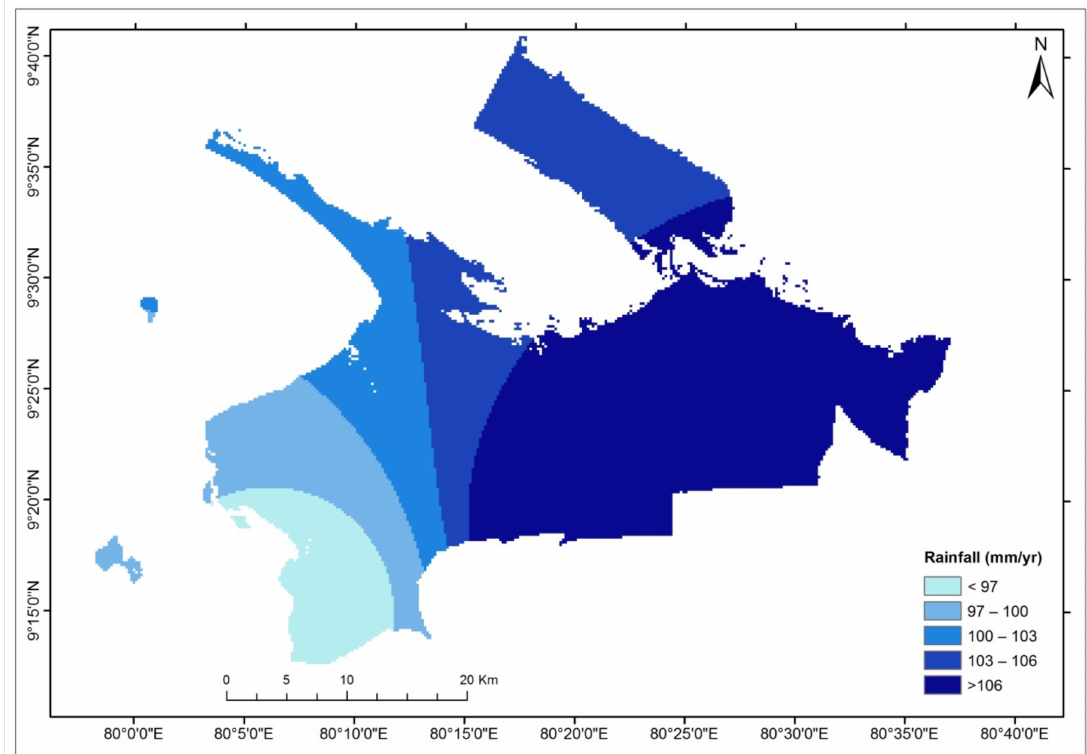
Figure 10. Rainfall distribution map of Kilinochchi